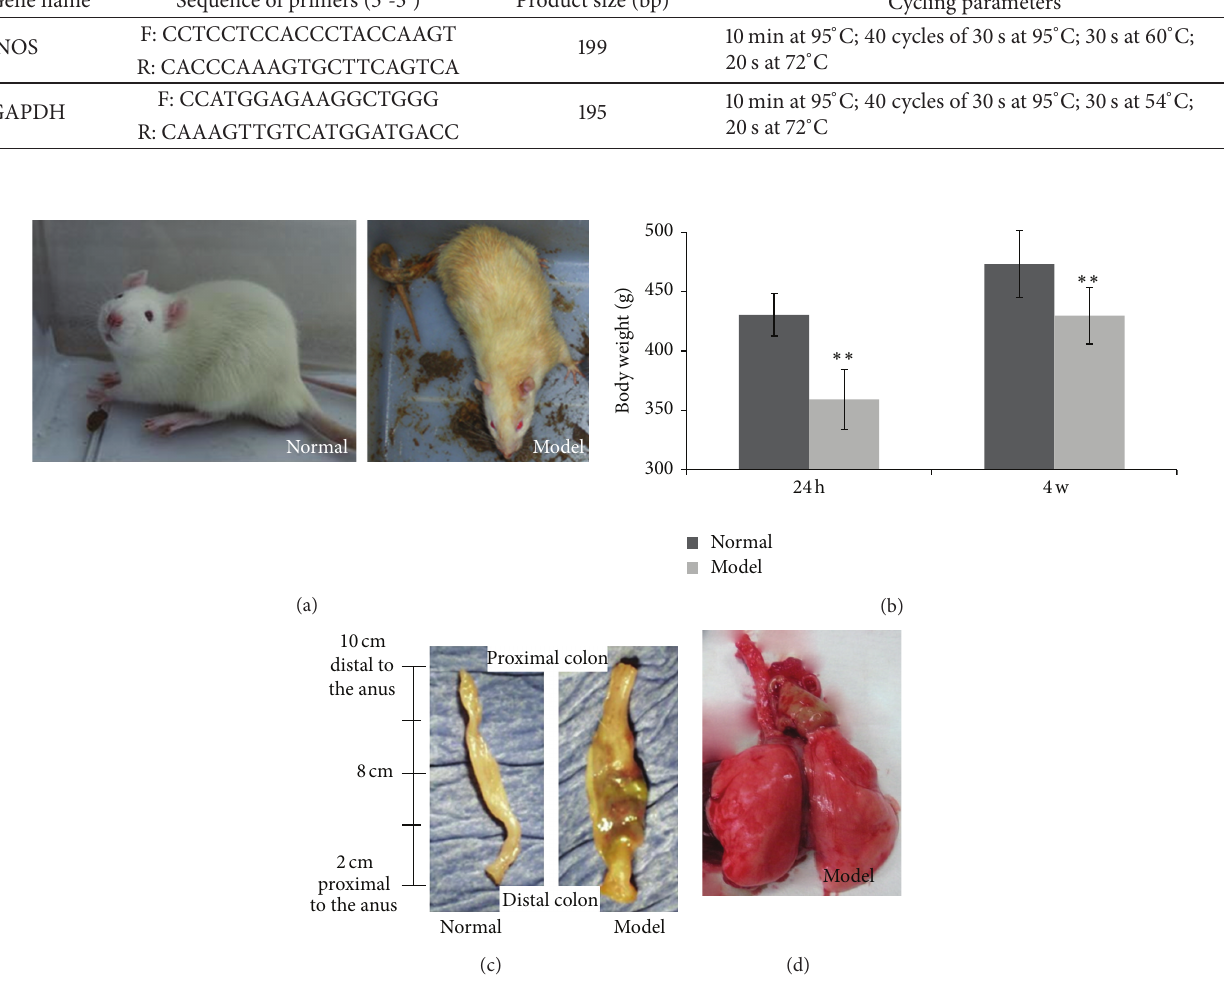
Figure 2: Overall changes in normal and UC rats. (a) Animal general state. Normal rats were active and glossy hair. Feces were hard and granular ellipsoid without mucus and blood. Immune-TNBS-ethanol-induced UC rats were poor, and symptoms such as reduced activity, drowsiness, loss of appetite, slowing response, and emaciation were observed. Hair color was greenish yellow withered. Feces appeared diarrhea mixed with blood, loose or even water. (b) The body weight of the immune-TNBS-ethanol-induced UC rats was significantly lighter than that of the normal rats ( ∗∗ , 𝑃 < 0.01 , 𝑛 = 10 ). (c) Normal operated and immune-TNBS-ethanol-induced UC rat large intestine. Rats were normal or TNBS-ethanol treated for 7 days before sacrifice. Well-advanced inflammation is apparent in the colon of UC rat model. (d) Immune-TNBS-ethanol-induced UC rat lungs. There is an abscess in the left